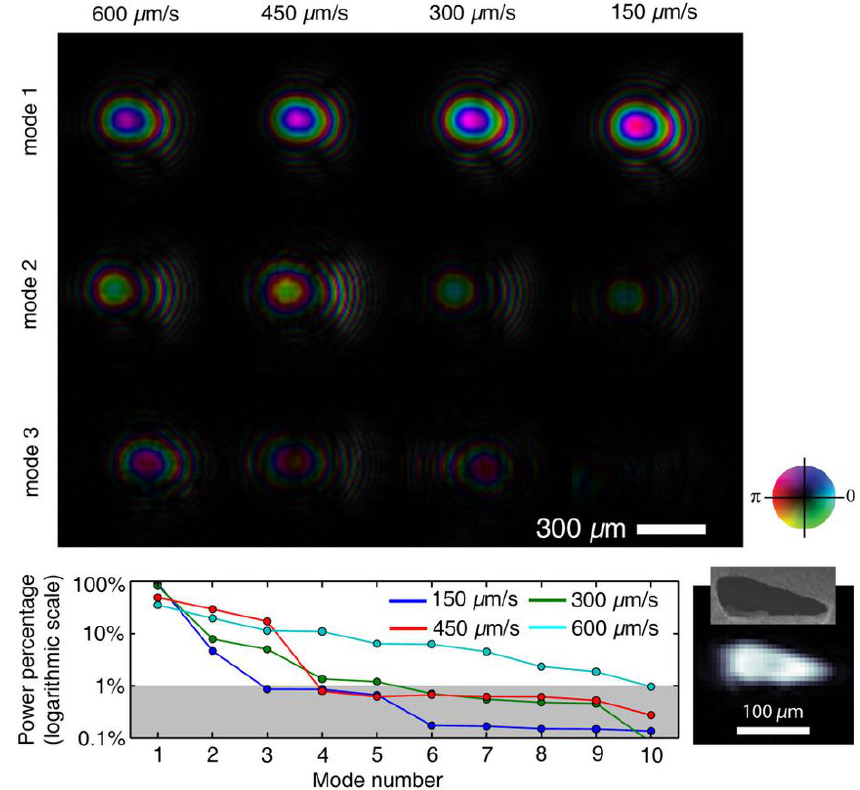
Figure 5. The top panel shows the three reconstructed illumination modes with the most powers for diffraction pattern collected at different scan speeds. The bottom panel shows the power percentage of the recovered modes. With increased scan speed, more illumination power is removed from primary modes and redistributed into other modes. The inset in the bottom-left corner shows the propagation of the reconstructed illumination wave back to pinhole plane. The shape and dimension are consistent with SEM measurement of the pinhole. Figure adapted from Ref [15]. Reprint permission granted. 2015 Macmillan Publishers